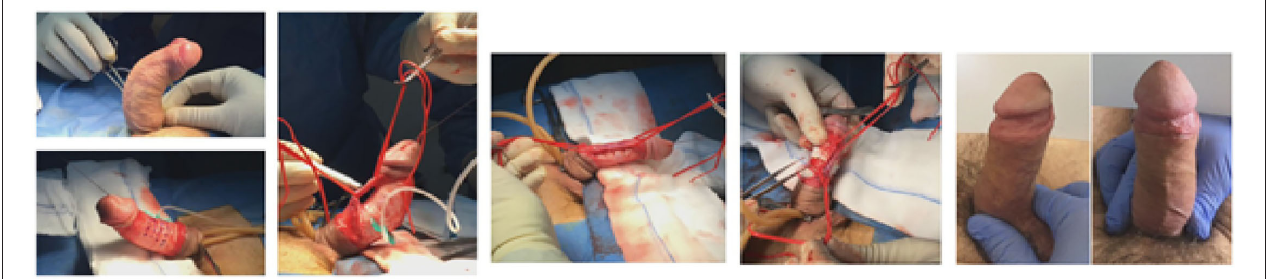
FIGURE 4 | Multiple transverse incisions patched with TACHOSIL ®